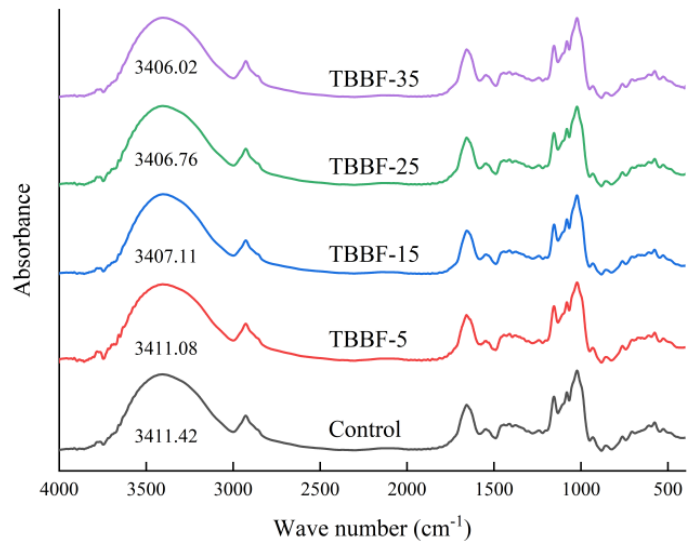
Figure 3. Fourier transform infrared spectra of Tartary buckwheat dried noodles. Control, TBBF-5, TBBF-15, TBBF-25, and TBBF-35 represent Tartary buckwheat dried noodles with 0%, 5%, 15%, 25%, and 35% substitution of Tartary buckwheat bran flour, respectively.